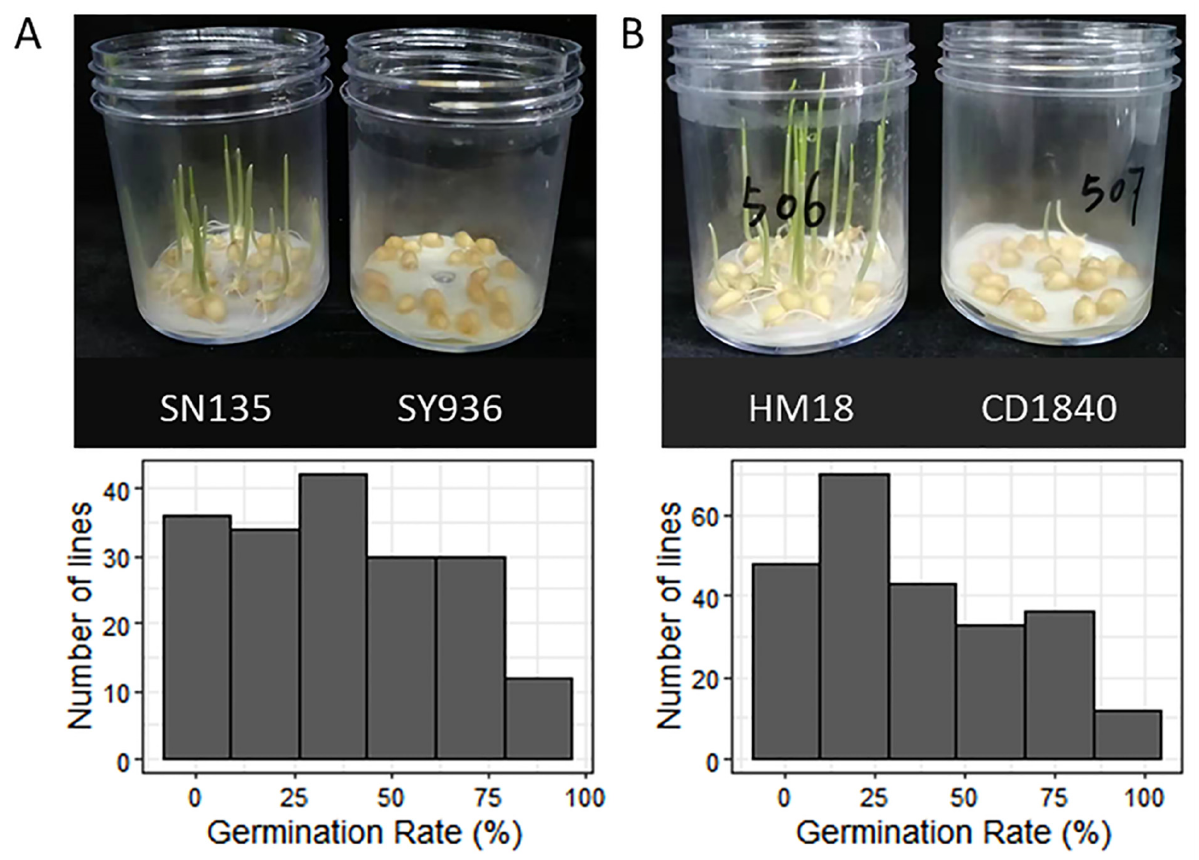
Figure 2. The phenotypic variation of waterlogging tolerance of the two biparental populations. ( A ) The seeds germination of parents Shannong 135 (SN135) and Siyang 936 (SY936) and distribution of the germination rate of the SN135 × SY936 population after waterlogging treatment. ( B ) The seed germination of parents Huaimai 18 (HM18) and CD1840 and distribution of the germination rate of population HM18 × CD1840 after waterlogging treatment.